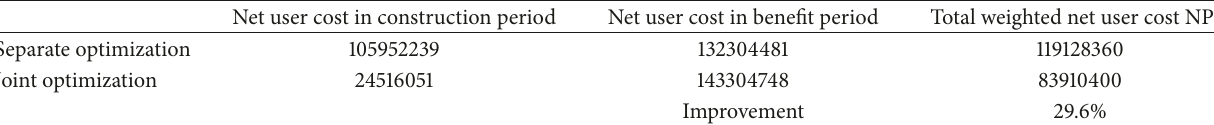
Table 3: System performance comparison for Scenario 1